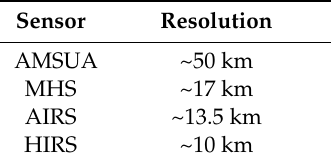
Table 7. Resolutions of satellite